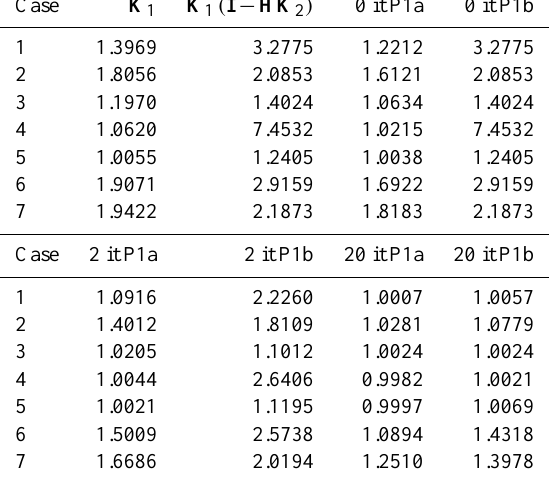
Table C1. Average error for different analysis formulations of pro- cess 1. Column 5 of the upper part shows the same result as col- umn 3 since it can be shown that without iterations, the formulations are equivalent. So column 5 of the upper part of the table essentially gives confidence that the implementation is correct. The average rel- ative error variance is based on 100000 independent realizations.